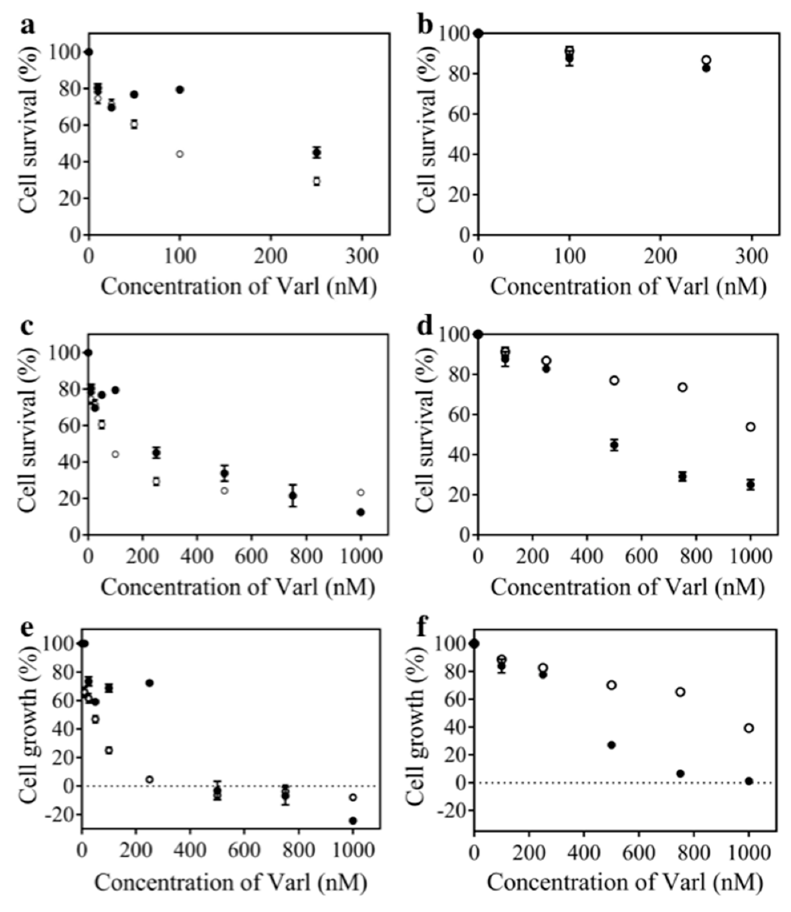
Figure 5. Cytotoxic effects of PEGAuNPsVarl ( О ) and varlitinib alone ( ● ) after 48 h a treatment on the cell survival (varlitinib concentration range from 10 to 300 nM) ( a , b ); cell survival (varlitinib concentration range from 10 to 1000 nM) ( c , d ) and on cell growth ( e , f ) of MIA PaCa-2 ( a , c , e ) and hTERT-HPNE ( b , d , f ), determined by a SRB assay.